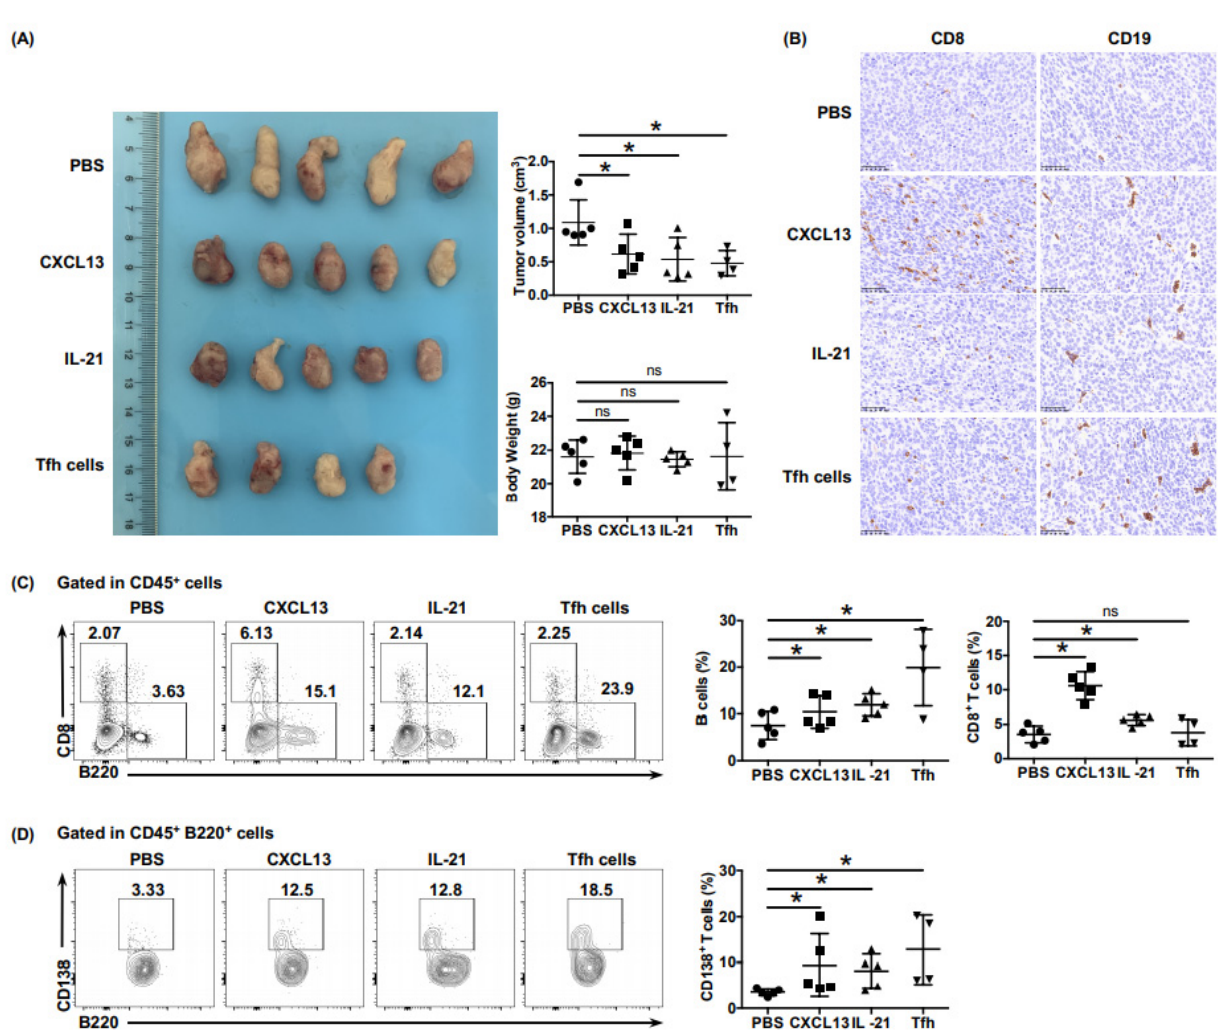
Figure 5. Tfh cells shape the immunoactive tumor microenvironment in a PDAC mouse model. ( A ) Resected tumors and tumor volumes in the subcutaneous PDAC mouse model treated with injection of PBS ( n = 5), rmCXCL13 ( n = 5), rmIL-21 ( n = 5), or Tfh cells ( n = 4), separately. ( B ) Representative images of immunohistochemistry of CD8 + T cells and CD20 + B cells of tumor tissues of tumor-bearing mice. Scale bars: 50 µ m ( C ) Representative flow cytometry data and the proportions of CD8 + T cells and B cells in the lymphocytes of tumor tissues of tumor-bearing mice. ( D ) Representative flow cytometry data and the proportions of CD138 + plasma cells in the lymphocytes of tumor tissues of tumor-bearing mice. Asterisks indicated the significance level of the p -value (ns: no significant difference, * p < 0.05).